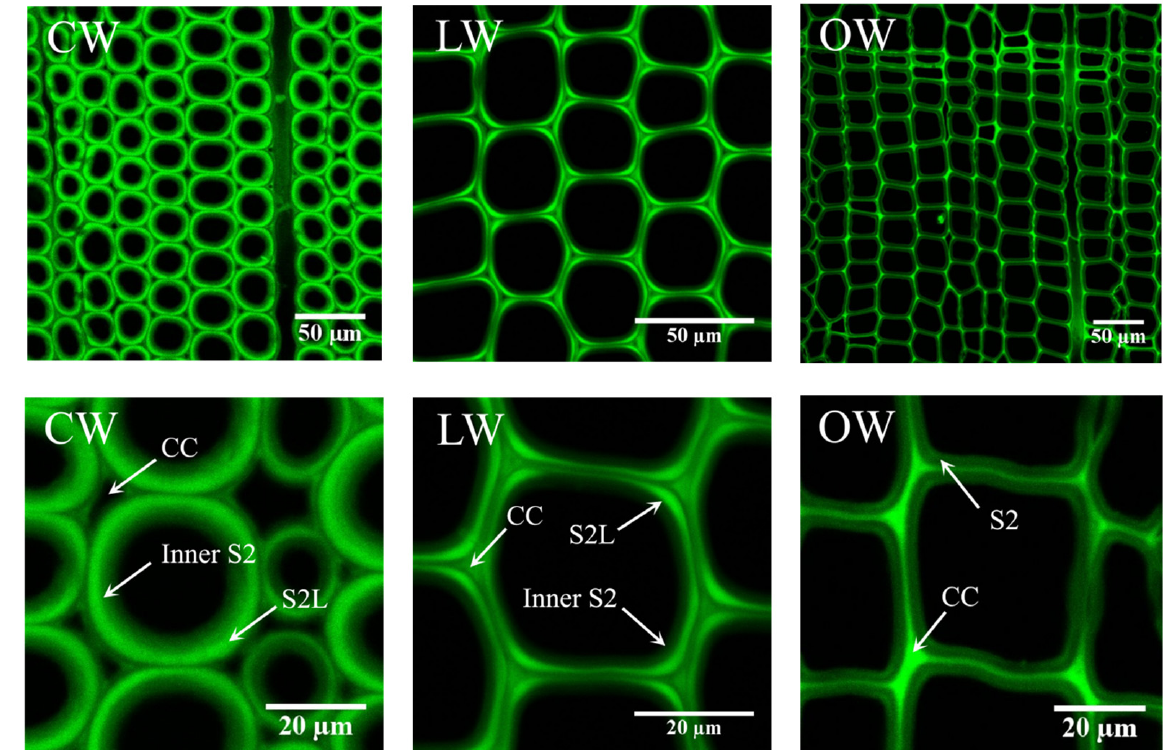
Figure 7. Lignin distribution in the cell walls of CW, LW, and OW tracheids. (CC: cell corner; S2L: the outer S2 layer).